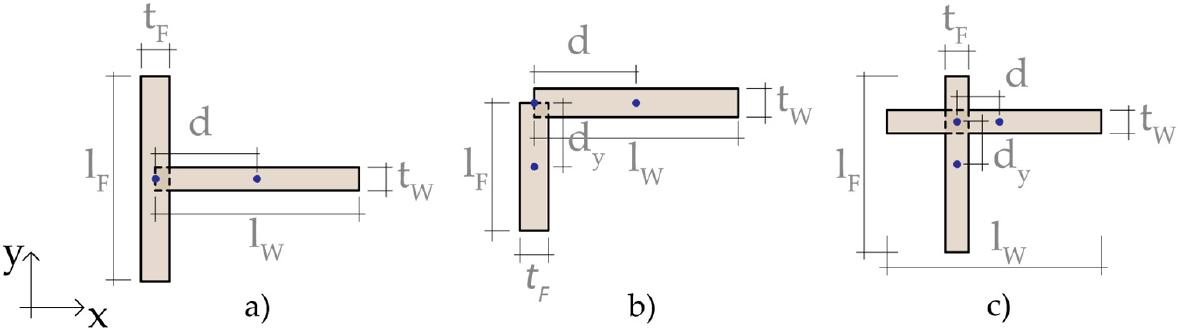
Figure 10. Possible configuration of connected piers: ( a ) intersection of external and internal walls; ( b ) corner intersection; ( c ) intersection of two internal walls.